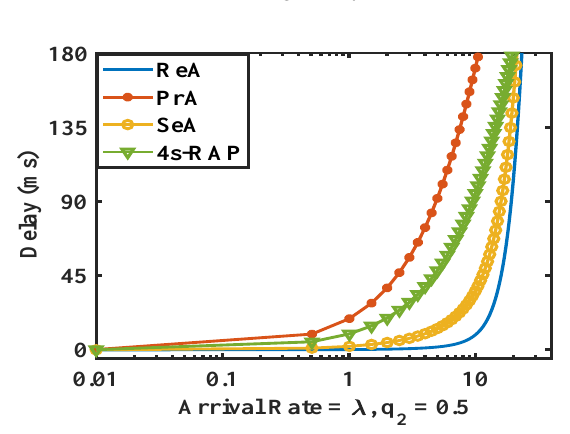
Figure 3. Average delay ( q 2 = 0.5).